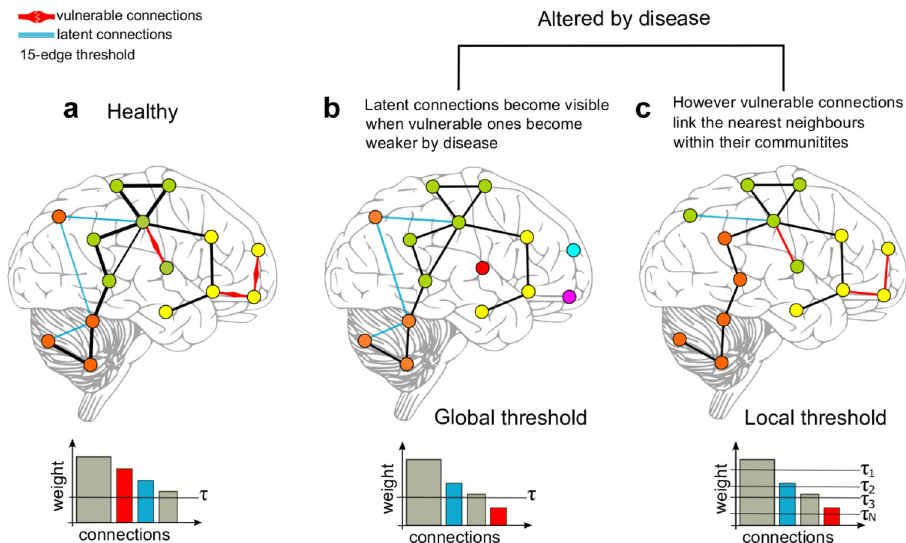
Fig. 9 Disease effects on local and global thresholding. a A toy model of healthy brain connectivity with “ known ” connections including vulnerable edges which can be targeted by disease, and latent connections which are weaker than vulnerable connections. b When the model is targeted by disease, the vulnerable connections become weaker and do not survive a global threshold. c Although weakened by disease, the vulnerable connections still connect the nearest neighbour nodes within their communities, and these connections are restored or made visible by local